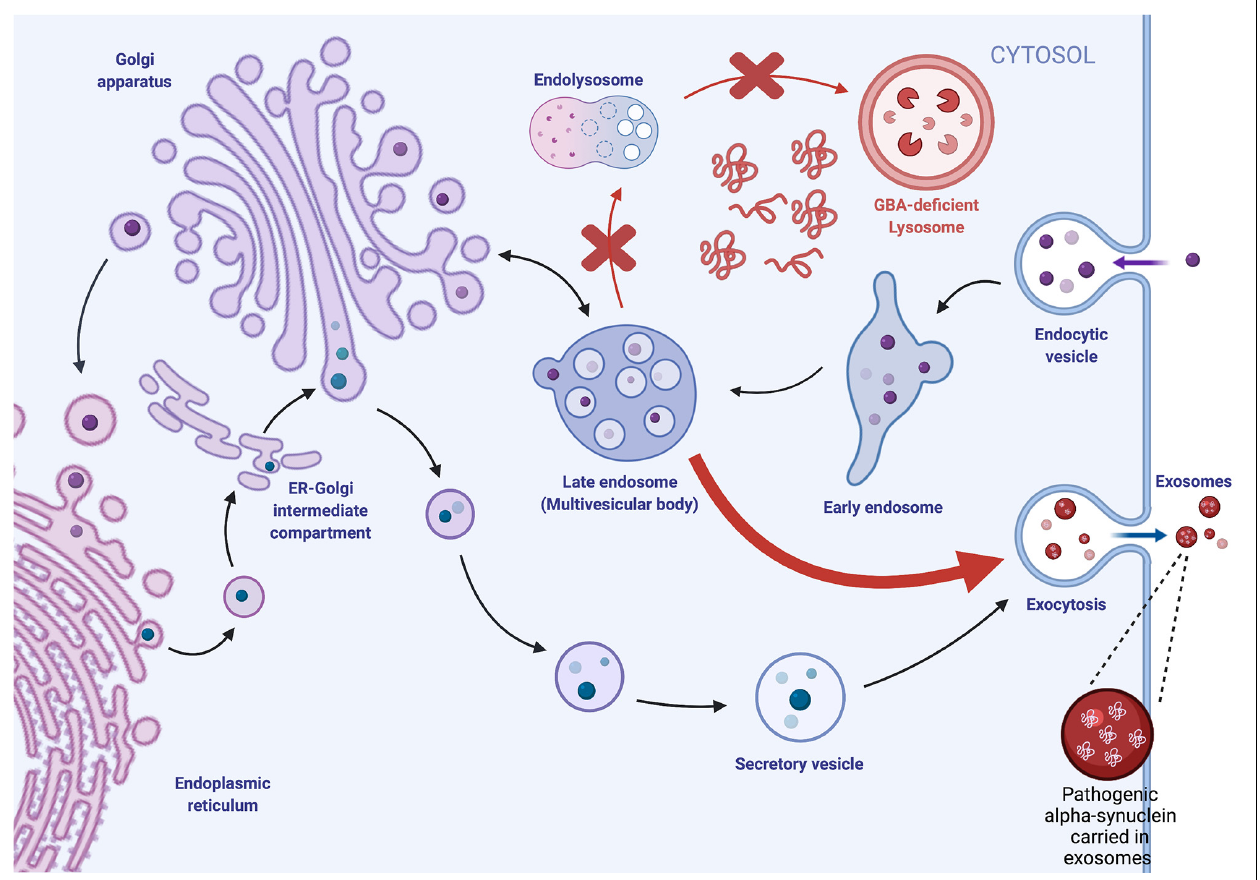
FIGURE 1 | Exosome biogenesis is dysregulated by lysosomal GBA deficiencies. Extracellular proteins are endocytosed and trafficked intracellularly via endocytes, where they undergo multiple rounds of inward budding to generate intraluminal vesicles (ILVs) within late endosomes/multivesicular bodies (MVBs). MVBs can fuse with the lysosome for degradation or fuse with the plasma membrane, where ILVs are released as extracellular vesicles (EVs). We hypothesize that GBA deficiency impairs lysosomal degradation, leading to the accumulation of intracellular protein aggregates and increased trafficking of the MVB to the plasma membrane for EV